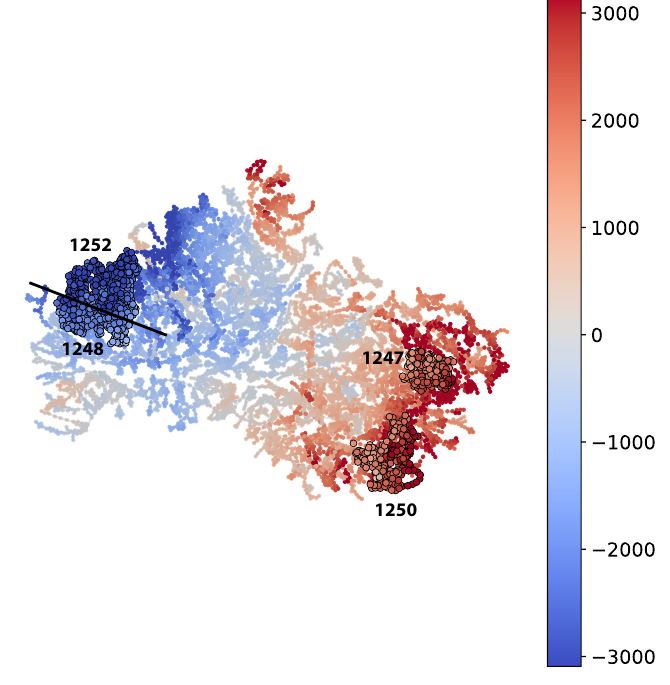
Figure 9. The M APPER graph. The groups 1247, 1248, 1250, and 1252 have highlighted nodes and are marked in the figure. The color-bar represents values, with respective coloring in the graph, for ∆ E El . The values are in kWh/heat. The line between the adjacent groups 1248 and 1252 is present for interpretability purposes. Number of data points and ∆ E El for each group; group 1247: 165, 2160 kWh/heat. Group 1248: 202, − 2740 kWh/heat. Group 1250: 213, 2350 kWh/heat. Group 1252: 355, − 2970